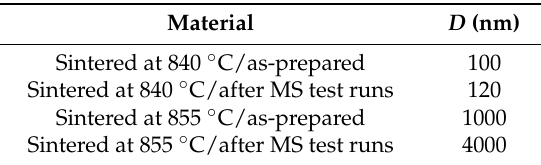
Table 2. SPS sintered FeMo alloy: average grain size D of samples sintered at 840 and 855 ◦ C, in as-prepared condition and after MS test